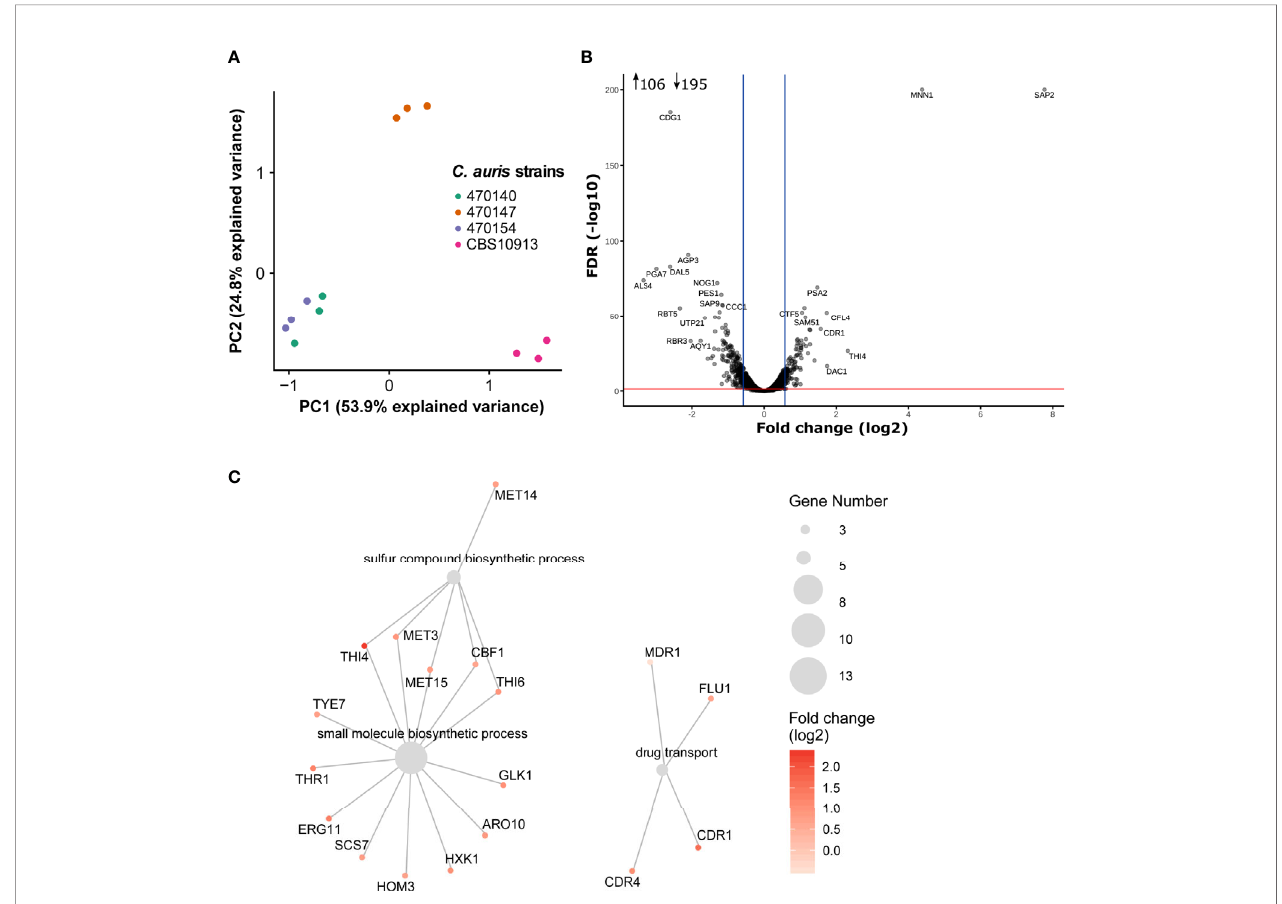
FIGURE 3 | Minor transcriptional variation drives divergent antifungal susceptibilities. (A) Principal component analysis result using normalized RNA-seq read counts from three biological replicates per strain. The two clinical isolates 470140 and 470154 show high similarity in their gene expression pro fi le and were used for further pairwise comparison. (B) Pairwise differential expression analysis of 470154 vs 470140. Fold-change (log2) in 470154 vs 470140 is plotted against the FDR. Top differentially expressed genes are labeled based on their homologues found in C. albicans . Blue lines indicate 1.5-fold change and the red line marks a FDR of 0.05. Number inserts depict differentially expressed genes (FDR < 0.05 and log2 fold change > 0.58 [~ 1.5-fold change] or < -0.58 [~ -1.5-fold change]) (C) GO term enrichment analysis of genes up-regulated (1.5-fold change with FDR < 0.05) in 470154 vs 470140. Grey dots represent signi fi cantly enriched GO terms and colored dots with lines show genes belonging to the corresponding GO term. Dot size indicates the number of genes within a GO term and the color code re fl ects expression changes in 470154 vs